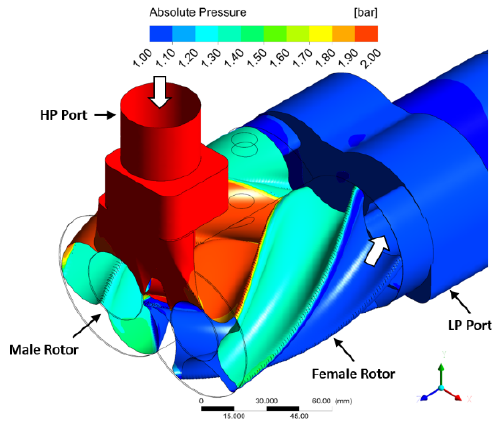
Figure 4. Pressure variation in twin-screw expander.